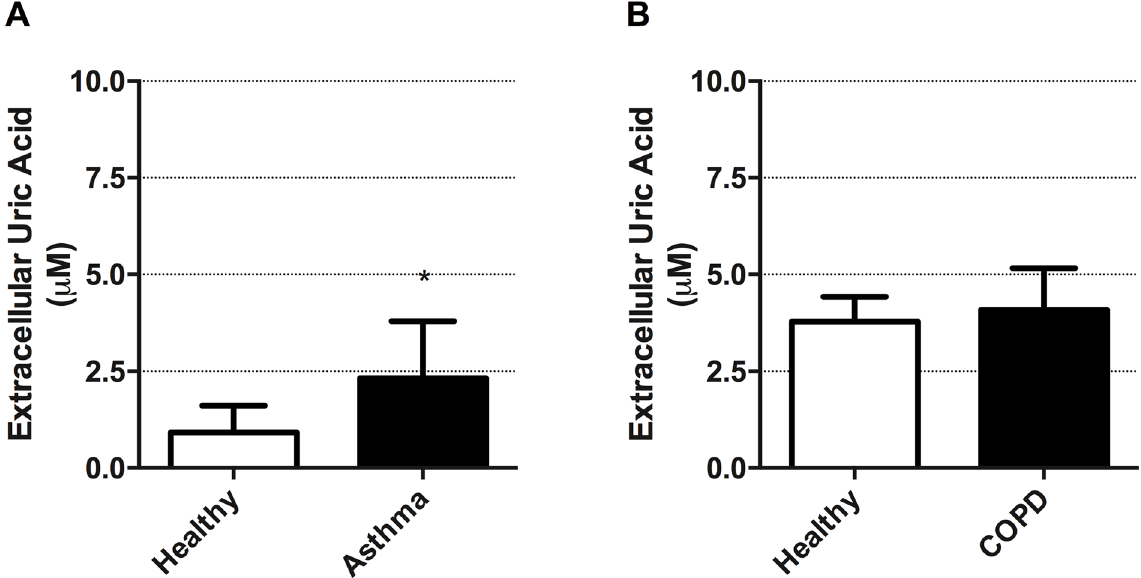
Fig 2. Primary airway epithelial cells from asthmatics, but not subjects with COPD, generate elevatedextracellular uric acid levels. ( A ) Cell culture supernatant analysisof uric acid levels in un-stimulated primary humanairway epithelialcells from healthy age-matched control subjects and asthmatics following24h of culture. ( B ) Cell culture supernatant analysisof uric acid levels in un- stimulatedprimary humanairway epithelialcells from healthy age-matched control subjects and those with COPD following24h of culture. Data represent mean +/- SD, n = 5–8. Significance is representedby * p < 0.05relative to healthycontrols. https://doi.org/10.1371/journal.pone.0184260.g002 resting HBEC-6KT human airway epithelial cells with allopurinol (500 μM) or MK-571 (20 μM) for 24h attenuated extracellular levels of uric acid from cultured human airway epithe- lial cells (Fig 3, p < 0.05). To determine if allopurinol and MK-571 have impacts at the tran- scriptional level on XDH and ABCC4, we determined gene expression in control unstimulated cells. Allopurinol had no impact on XDH or ABCC4 gene expression. In contrast, MK-571 attenuated XDH gene expression and augmented ABCC4 gene expression (Fig 3B–3C).